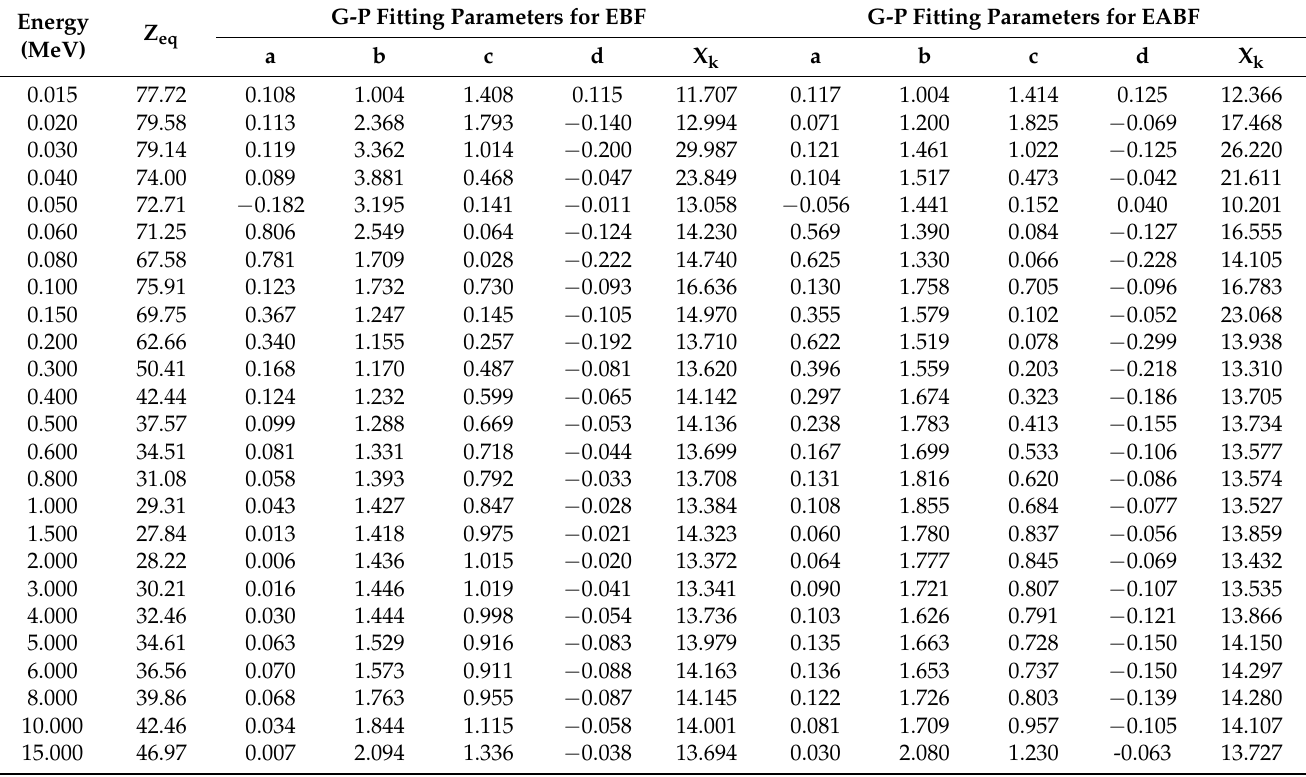
Table 8. (EBF and EABF) G–P fitting coefficients (b, c, a, Xk and d) of LBi50Eu0.5 glass